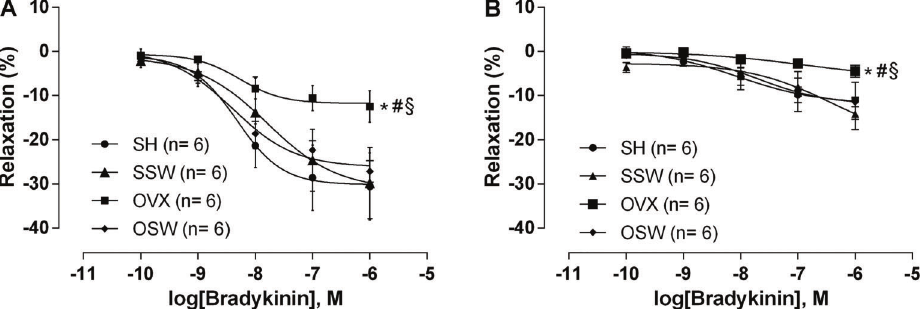
Figure 1. Endothelium-dependent vasodilator response to bradykinin. A , Estrogen de fi ciency in spontaneously hypertensive rats led to endothelial dysfunction, which was prevented by 8 weeks of swimming training. B , Pre-incubation with nitric oxide synthase inhibitor (L-NAME, 100 m M) reduced the endothelium-dependent vasodilation in all groups. SH: sham-operated; SSW: sham plus swimming training; OVX: ovariectomized; OSW: ovariectomized plus swimming training. Data are reported as means ± SE. *P o 0.05 vs SH,